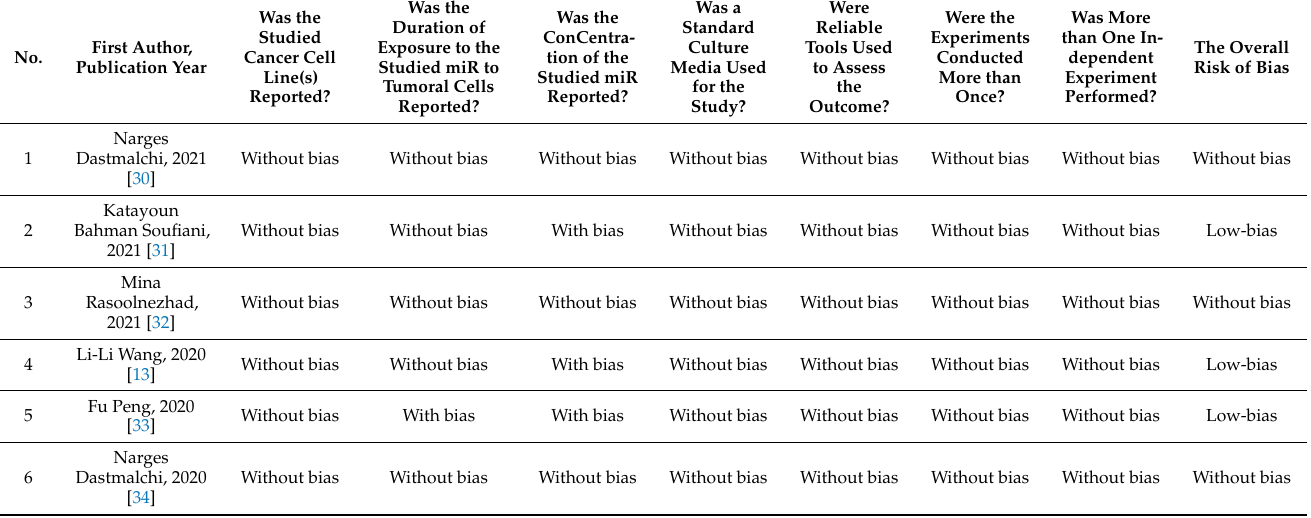
Table 3. Evaluating the potential bias among in vitro